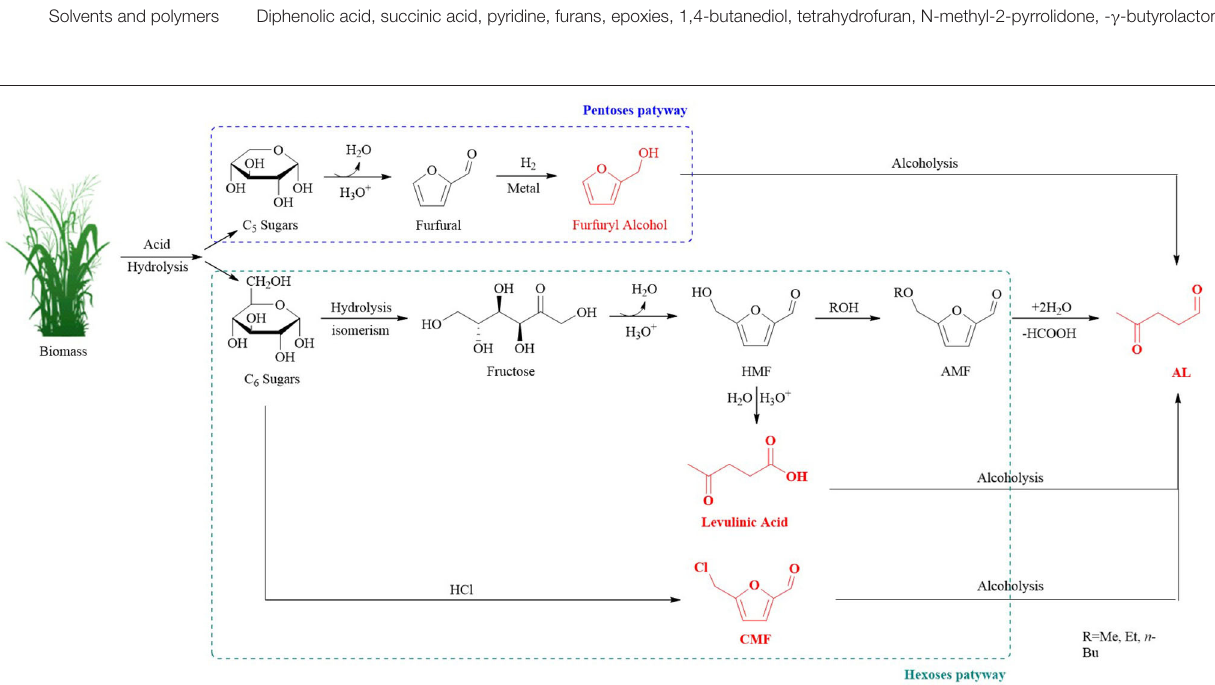
and only ∼ 4% NO x emissions upon blending in diesel (Windom et al., 2011). Therefore, research has mostly been devoted toward the effective synthesis of